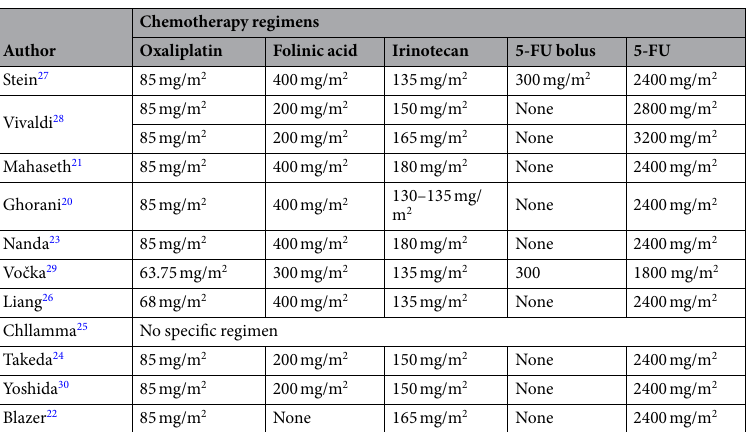
Table 2. The detailed regimens of modified FOLFIRINOX.